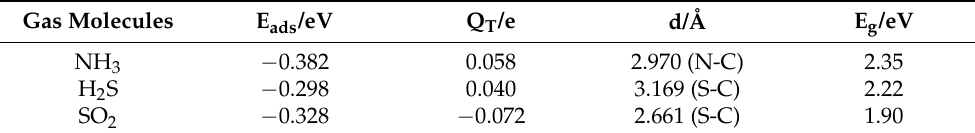
Table 2. Adsorption energy (E ads ), the Hirshfeld charge transferred from PG to gases (Q T ), adsorption distance (d), and band gap (E g ) of different gases adsorbed on pristine PG.